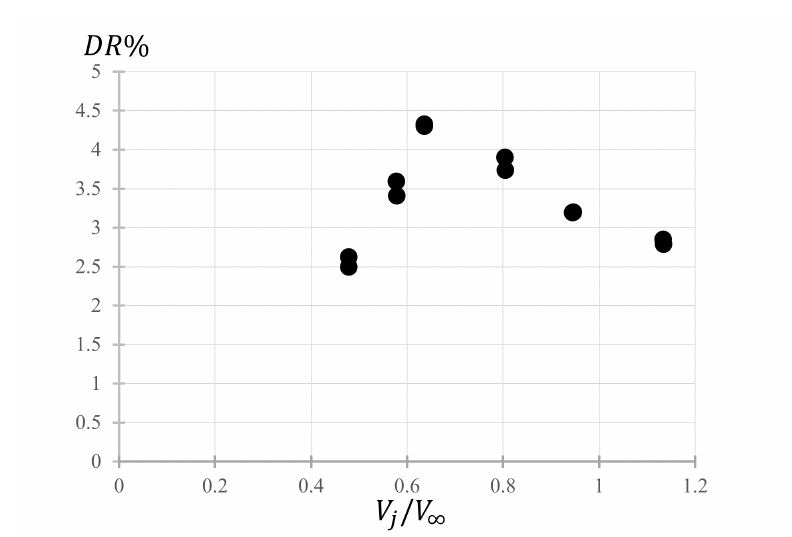
Figure 7. Drag reduction for symmetric forcing ( V lat / V ∞ = V low / V ∞ = V up / V ∞